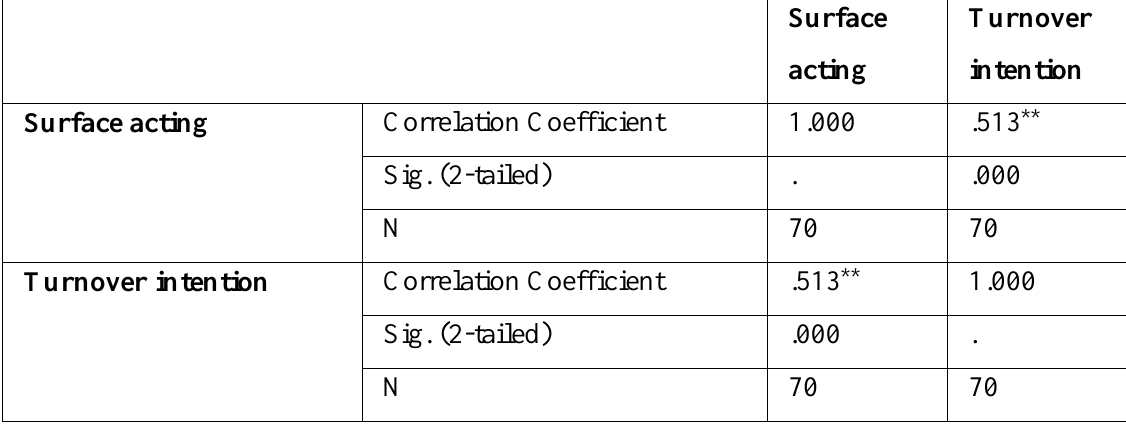
Table 4: Correlation between Surface Acting and Turnover